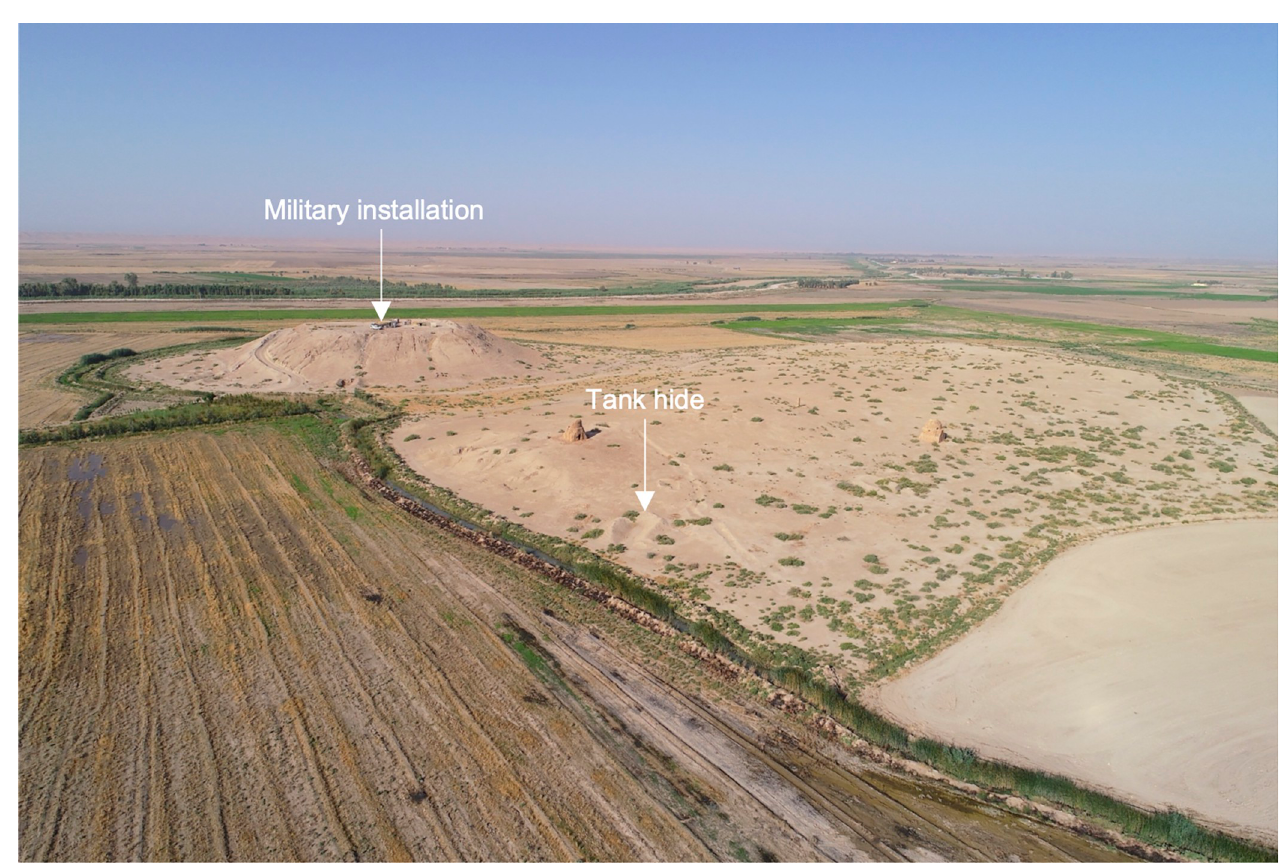
Fig 7. UAV-captured aerial view of Tepe Kalan (SRP 18) showing conflict-related damage (facing southwest). See Fig 1 for site location. Image courtesy of the Sirwan Regional